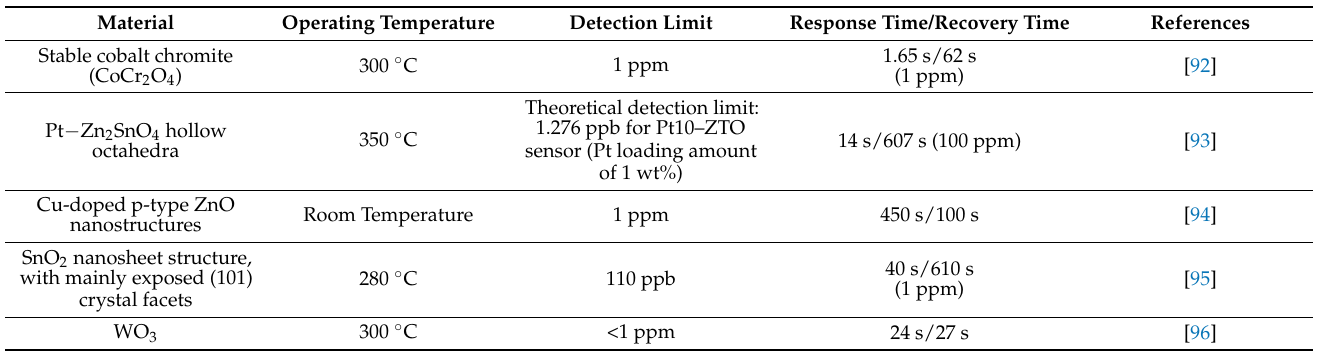
Table 5. Recently Developed Acetone-Selective MOS